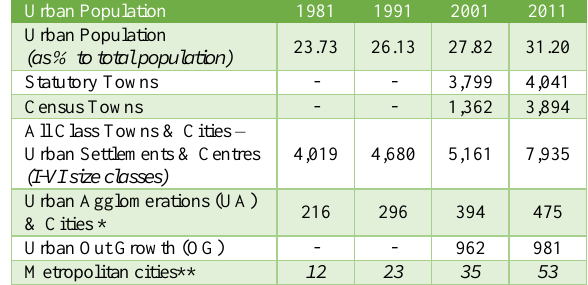
Table 2. Urban Population – Towns, Cities and Urban Agglomerations in India: 1981 to